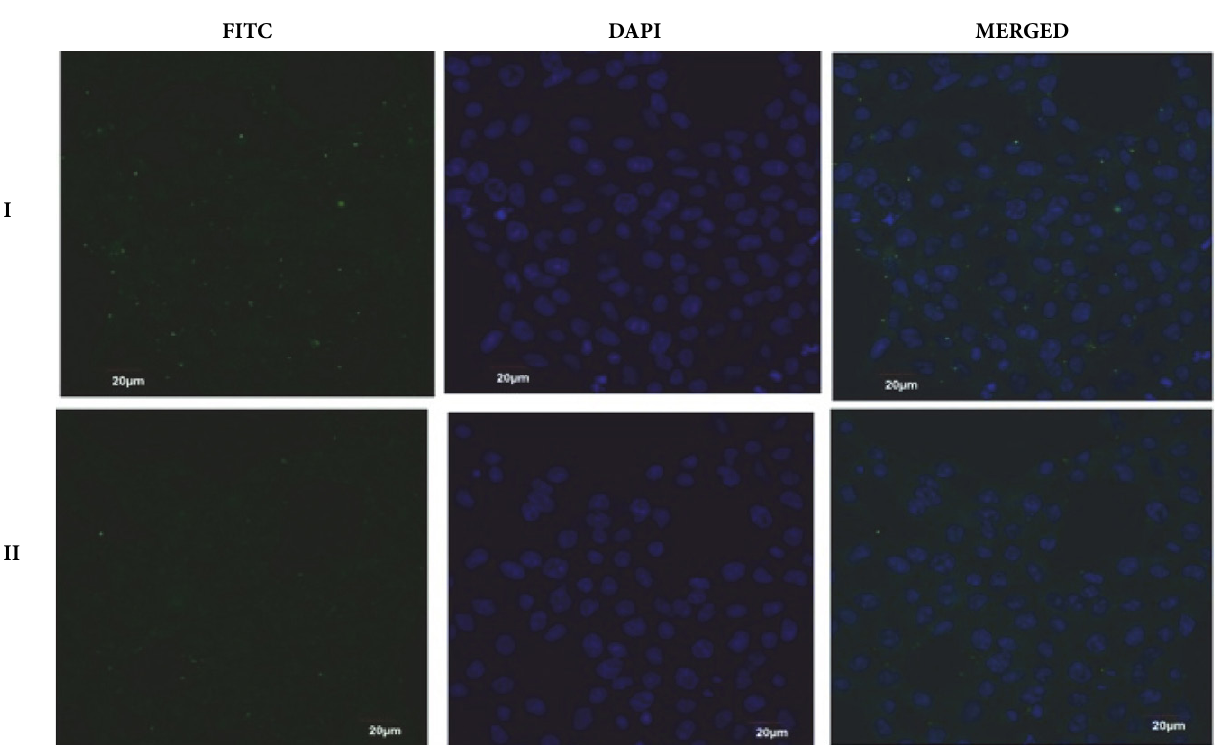
Fig. 4 . Cellular internalization study of fluorescein isothiocyanate labelled lomustine loaded lipid nanostructures (FITC-LNL-2) in C6 rat glioma cells (0.5 h incubation) by confocal laser scanning microscopy at I) 50 ng/ml; II) 100 ng/ml. The nucleus was stained with 4ʹ,6-diamidino-2-phe- nylindole (DAPI).